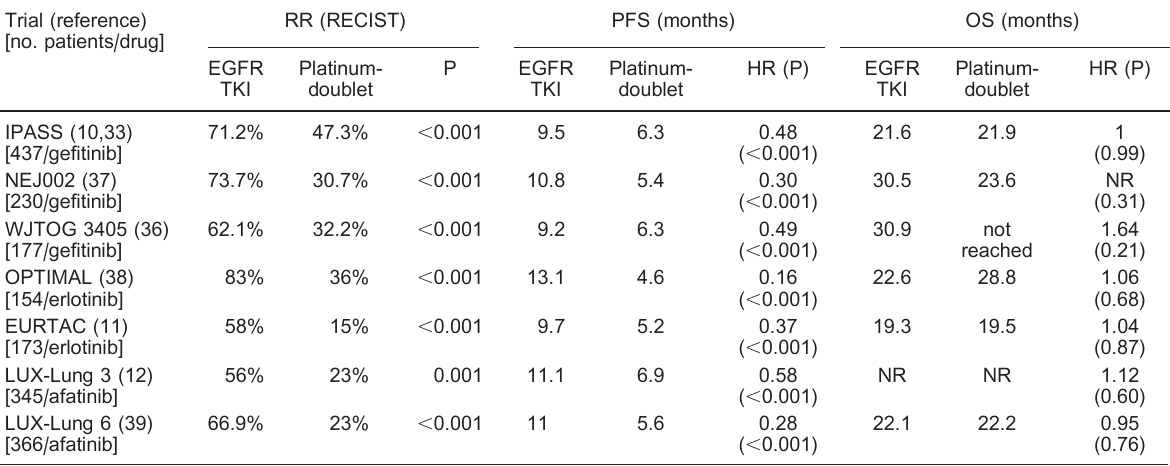
Table 1. Clinical trials of gefitinib, erlotinib and afatinib against platinum-doublet chemotherapy as first line therapy for advanced EGFR mutated NSCLC. Trial (reference) [no.